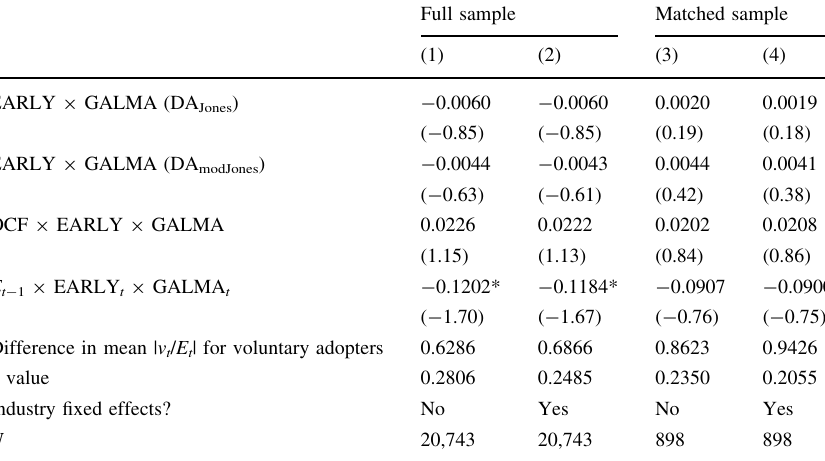
Table 11 Results of the financial reporting properties for the subsample of voluntary